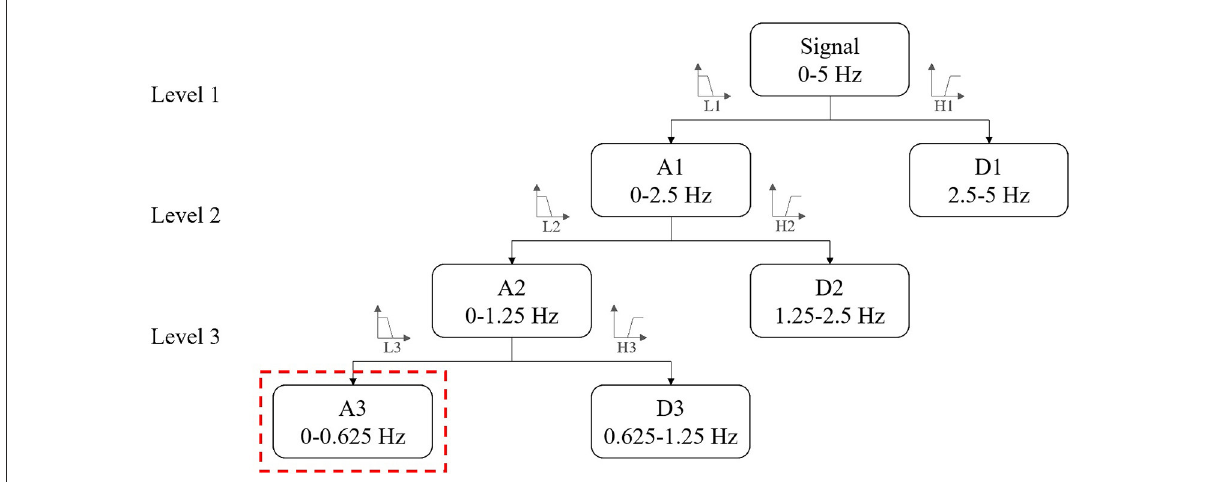
FIGURE5 The three-level decomposition tree for discrete wavelet transform. A3 with the frequency range of 0–0.625Hz was selected to compute wavelet